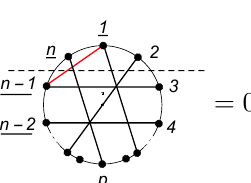
Figure 4 . This factorization cut vanishes since the dashed black line cuts six lines (more than four), five black and one red (rule II).